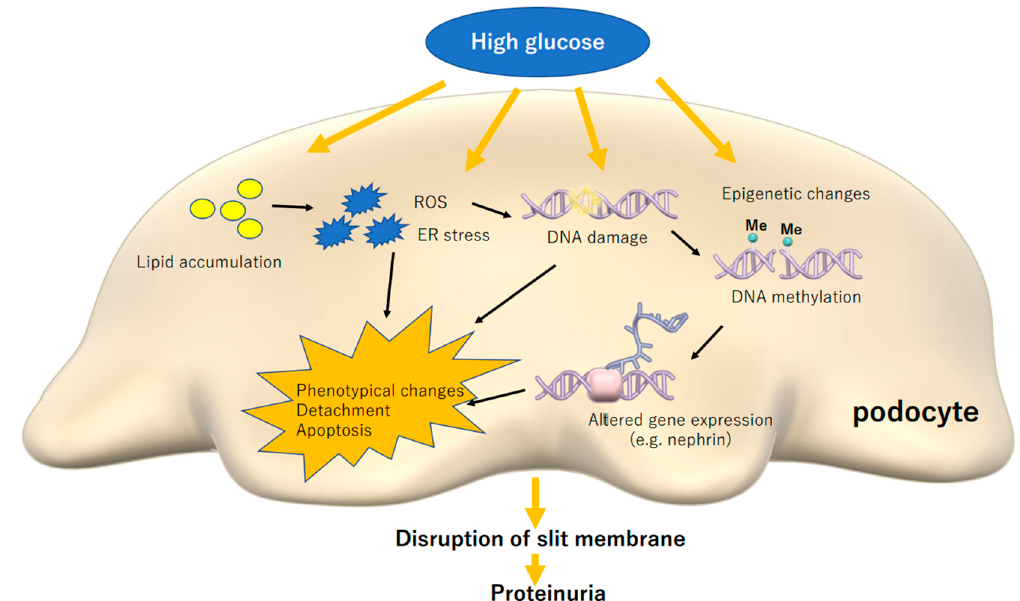
Figure 1. High glucose and induced lipotoxicity causes stress reactions in podocytes, which can cause phenotypical changes, detachment and apoptosis, leading to disruption of slit membrane and proteinuria. ROS: reactive oxygen species, ER: endoplasmic reticulum.